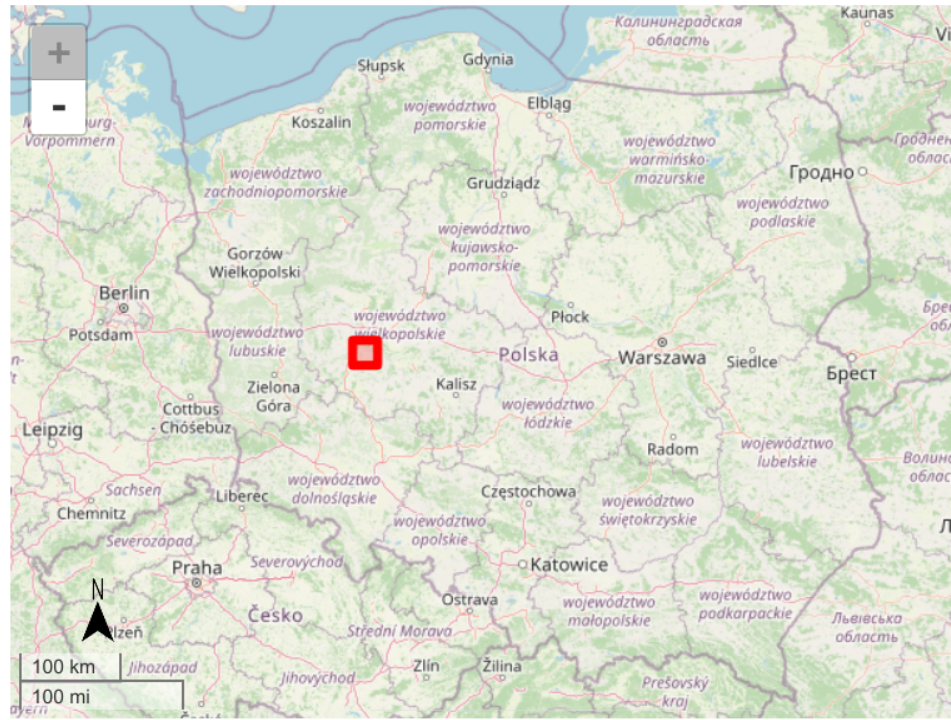
Figure 2. Test area location (UL: 16 ◦ 37 (cid:48) 21.43 (cid:48)(cid:48) E; 52 ◦ 14 (cid:48) 31.3 (cid:48)(cid:48) N; LR: 16 ◦ 57 (cid:48) 48.28 (cid:48)(cid:48) E; 52 ◦ 1 (cid:48) 3.74 (cid:48)(cid:48) N). Data source: